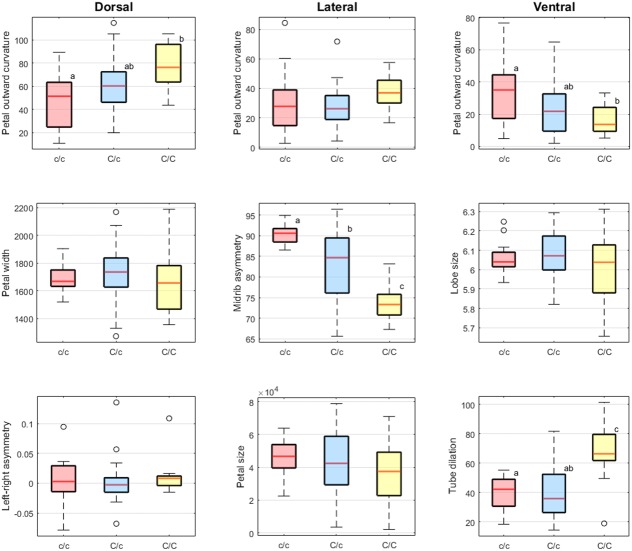
Boxplots of the defined traits. The lowercase alphabet near the box presenting the grouping result of Scheffé’s multiple comparison test.